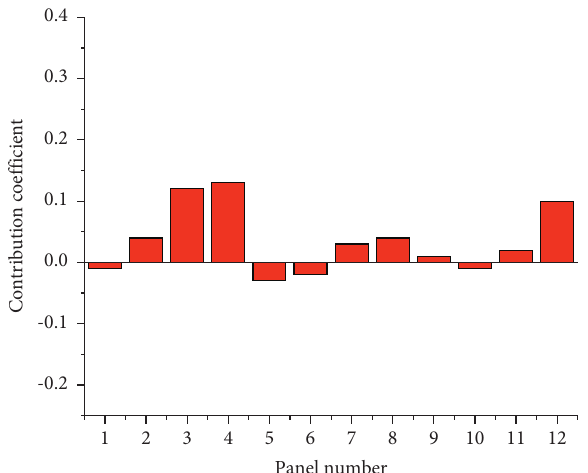
Figure 11: The panel acoustic contribution at 100 Hz.